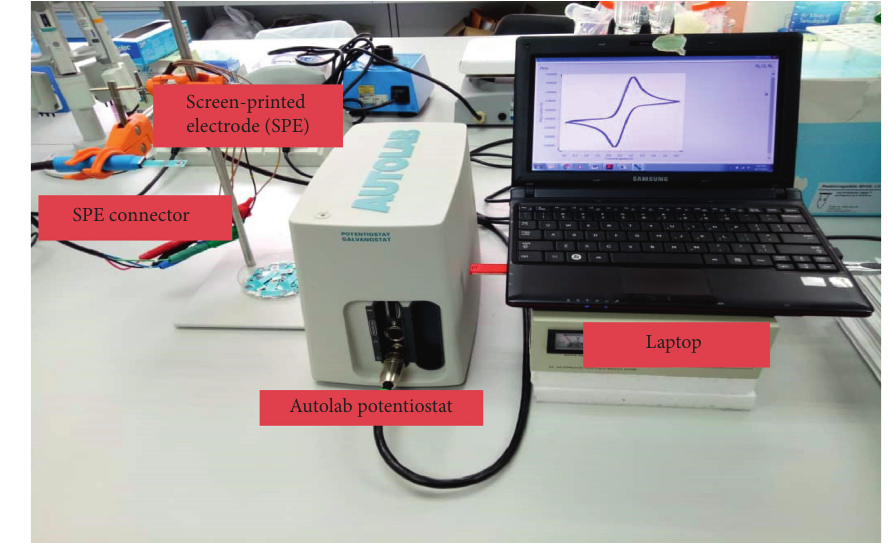
Figure 3: Schematic diagram of the electrochemical analysis setup using a screen-printed electrode (SPE).